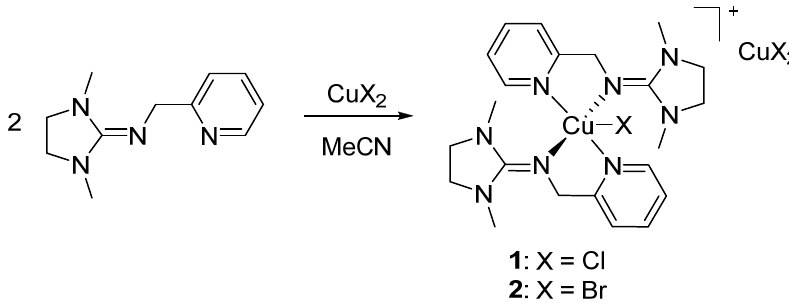
Cl]CuCl ( 1 ) and [Cu(DMEGpy) 2 2